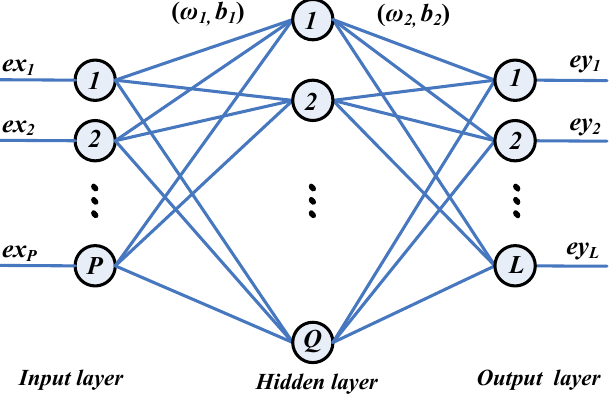
Figure 14. Architecture of a simple BP neural network system.